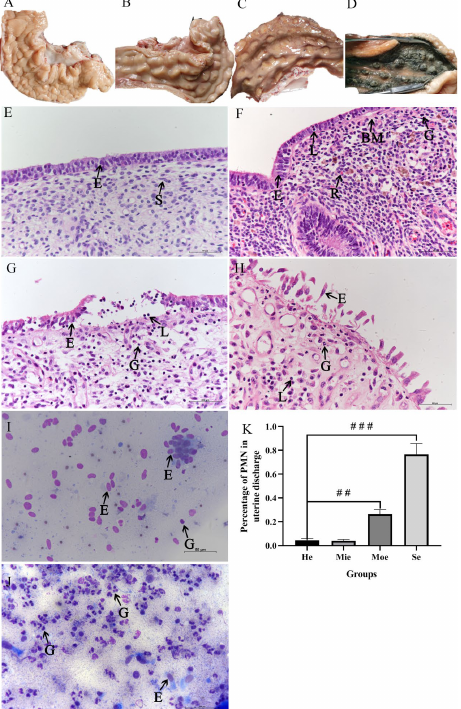
Figure 1. Histopathologic and cytological characterization of the bovine uterus. ( A – D ) Healthy dairy cow uterus (He), dairy cow uterus with mild endometritis (Mie), dairy cow uterus with mod- erate endometritis (Moe), and dairy cow uterus with severe endometritis (Se), respectively. ( E – H ) Corresponding histopathological characterization of samples in panels ( A – D ). ( I ) Representative cytology by cytobrush image of healthy dairy cow uterus. ( J ) Representative cytology by cytobrush image of the uterus with endometritis. ( K ) Percentage of PMNs of UD in He, Mie, Moe, and Se groups. Different fields were randomly selected, 100 cells were counted, and the percentage of PMN was calculated. E indicates a luminal epithelial cell, G denotes a granulocyte, L is a lymphocyte, S indicates a stroma cell, and R is a red cell, BM is a basement membrane. Images were magnified 400 ×. One-way ANOVA analysis was used to compare to the control group. ## p < 0.01, ### p < 0.001.